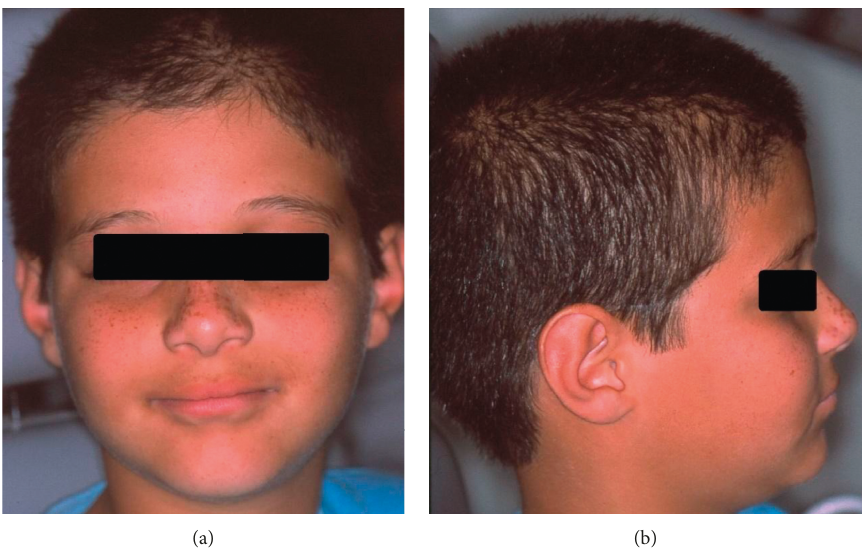
Figure 1: Patient 1. Child with hidrotic ED had sparse hair and eyebrows and discrete perioral pigmentation (a and